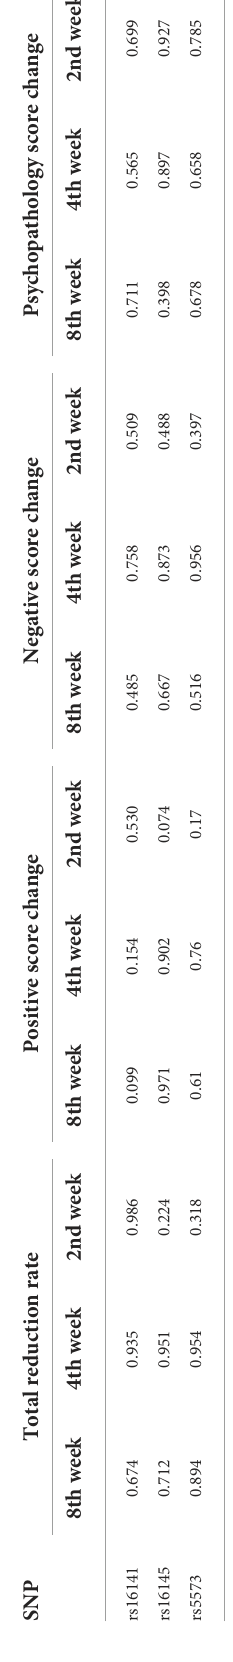
TABLE 1 Descriptive statistics for patient-related variables with regard to